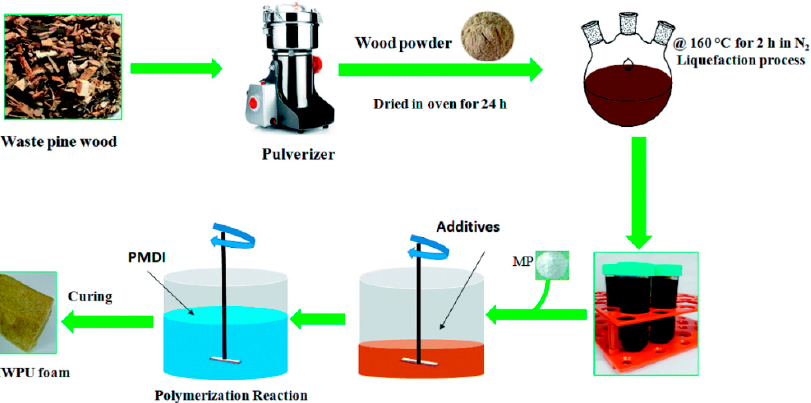
Figure 16. Schematic showing waste pine wood liquefaction and synthesis of melamine phosphate polyurethane foam.